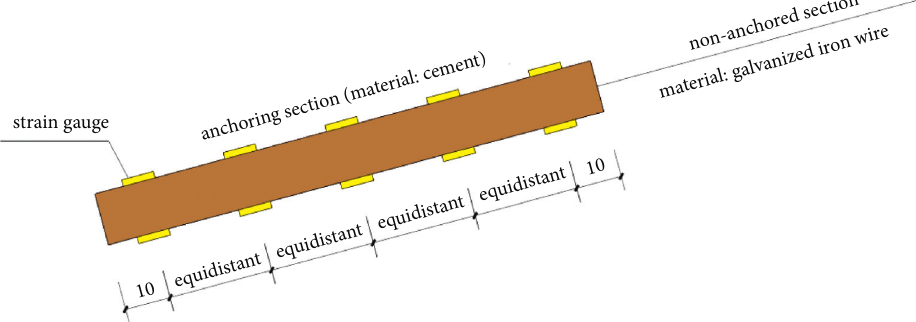
Figure 5: Arrangement of strain gauges on the anchor rod (unit: mm).